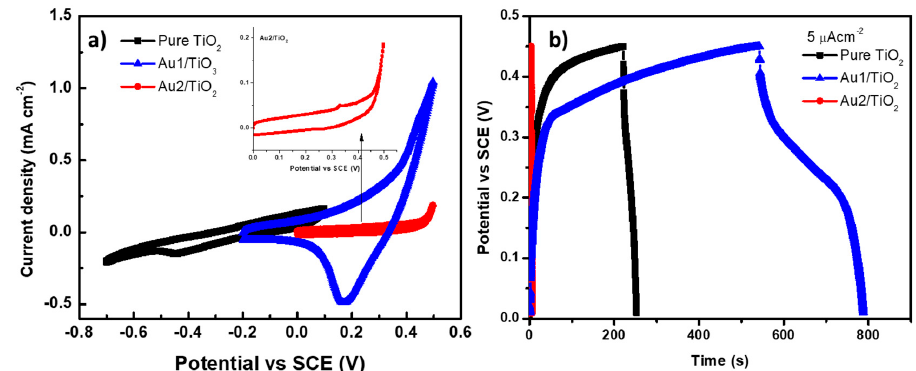
Figure 5. ( a ) CV curves measured at a scan rate of 50 mVs − 1 for pure TiO 2 , Au1/TiO 2 , and Au2/TiO 2 samples and ( b ) GCD curves measured at a current density of 5 µAcm − 2 .